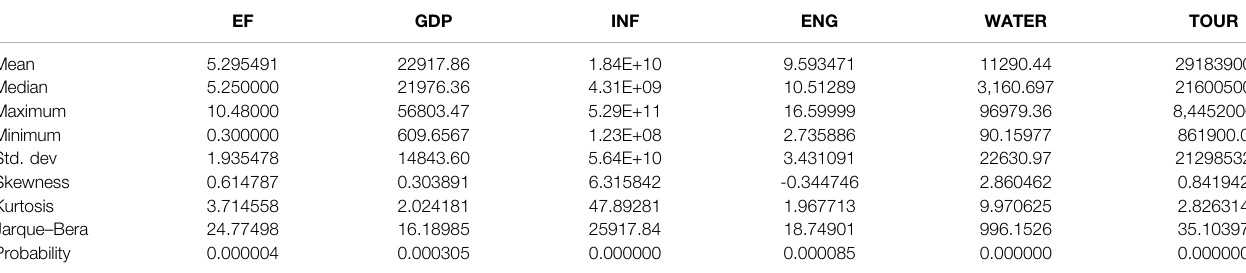
TABLE 1 | Descriptive statistics.